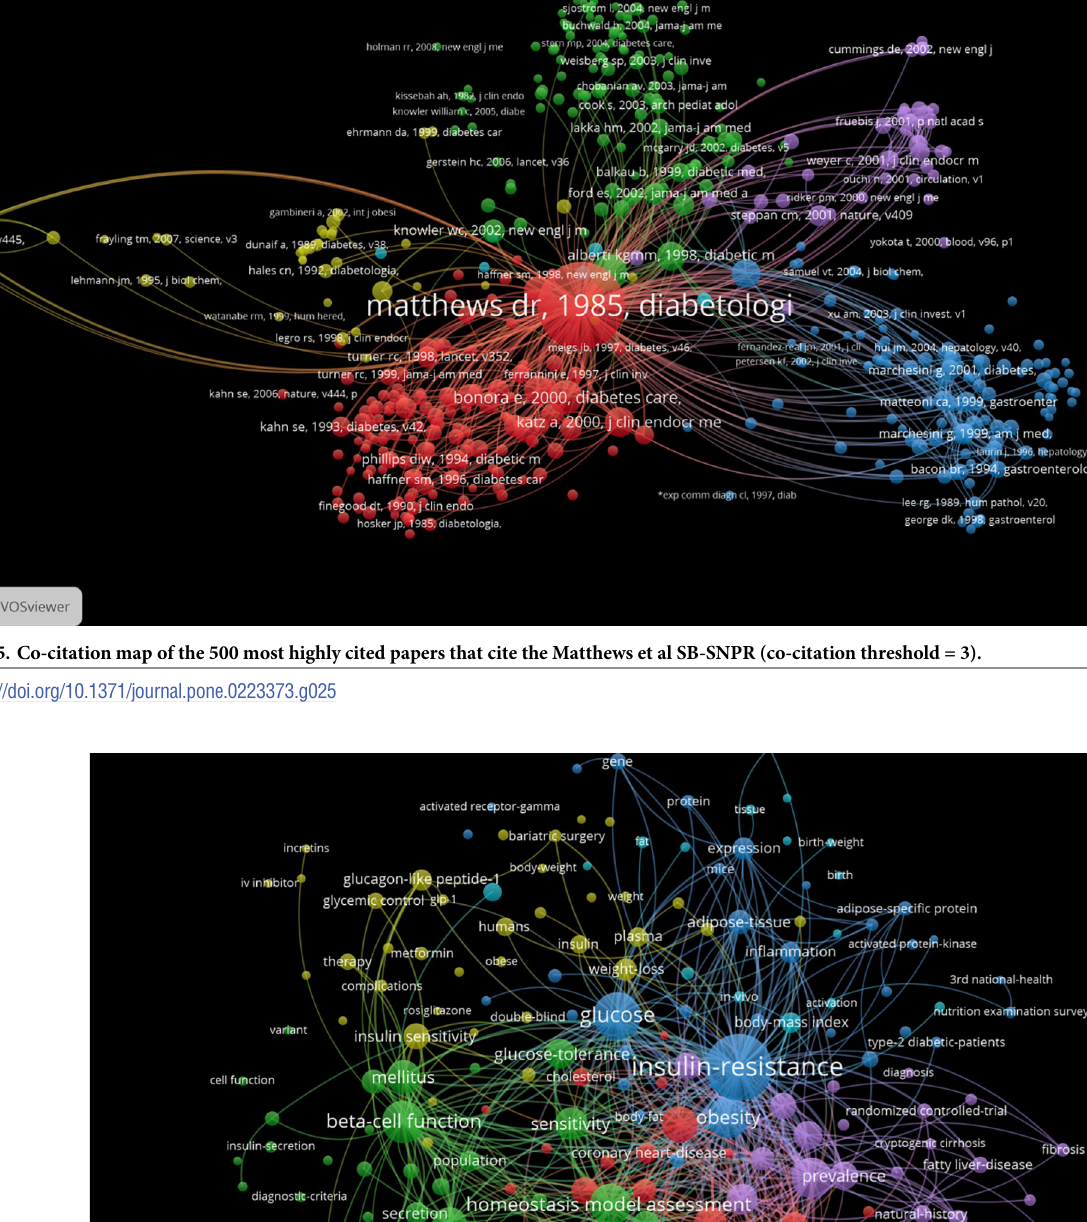
PLOS ONE | https://doi.org/10.1371/journal.pone.0223373 October 18, 2019 30 /